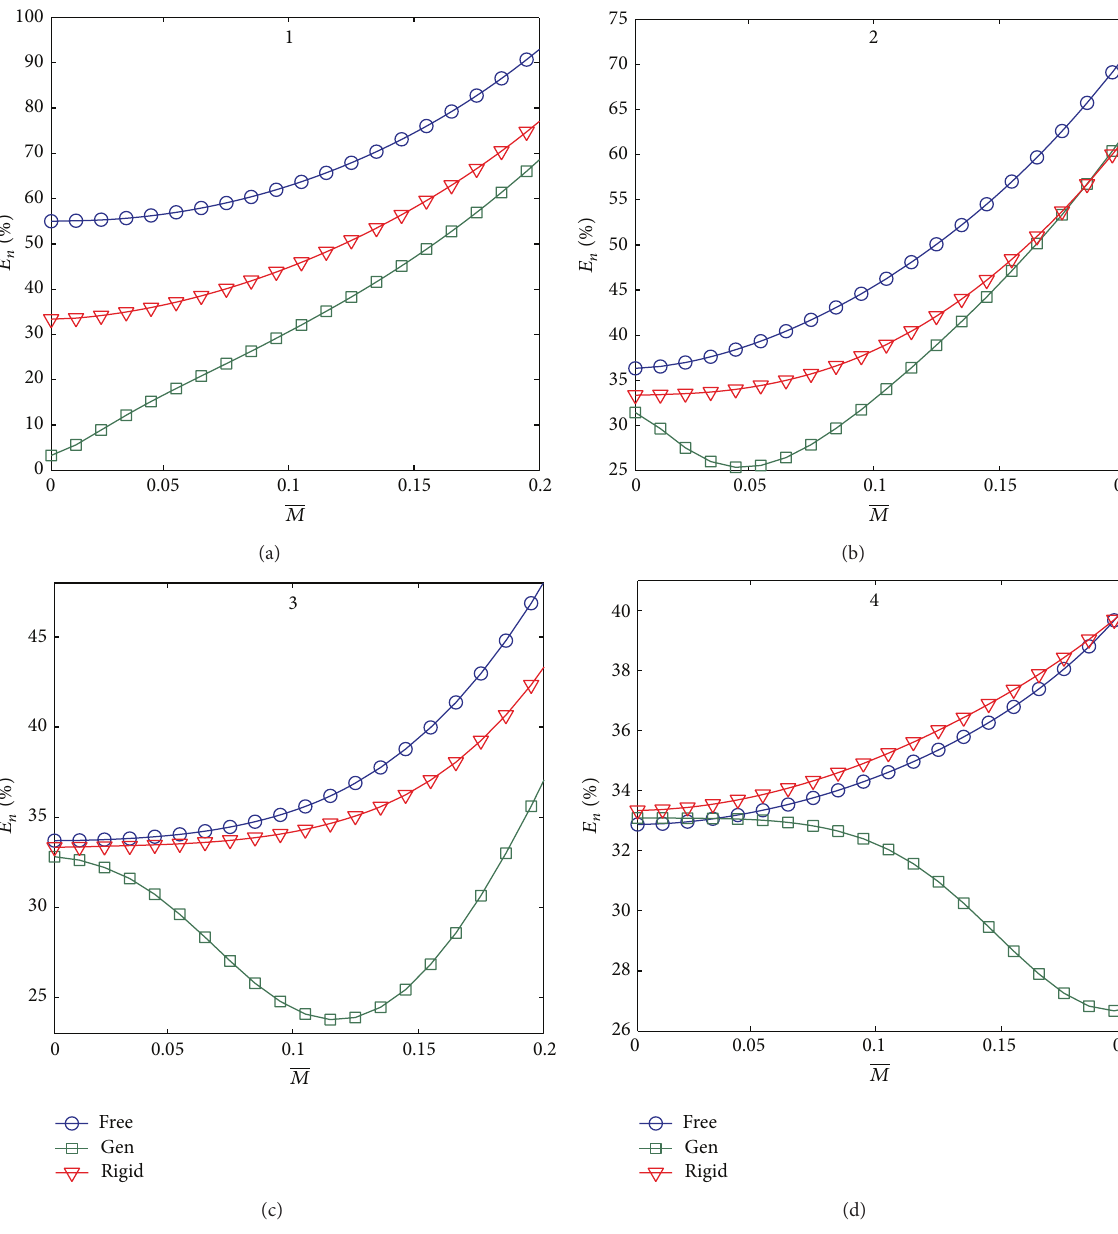
Figure 9: (Color online) Comparison of the measurement errors of the first four axial modes among the three different boundary configurations in the laminar flow. See Figure 2 for legend